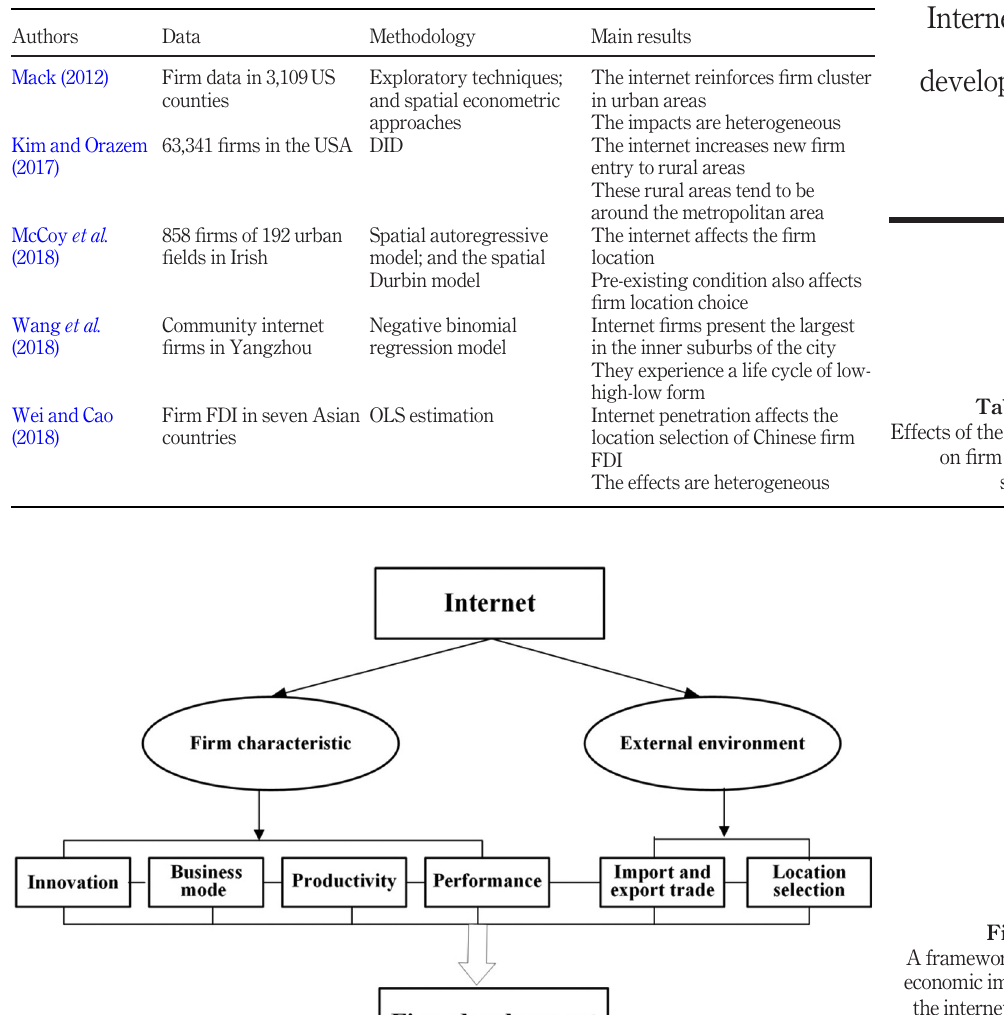
Figure 1. A framework on